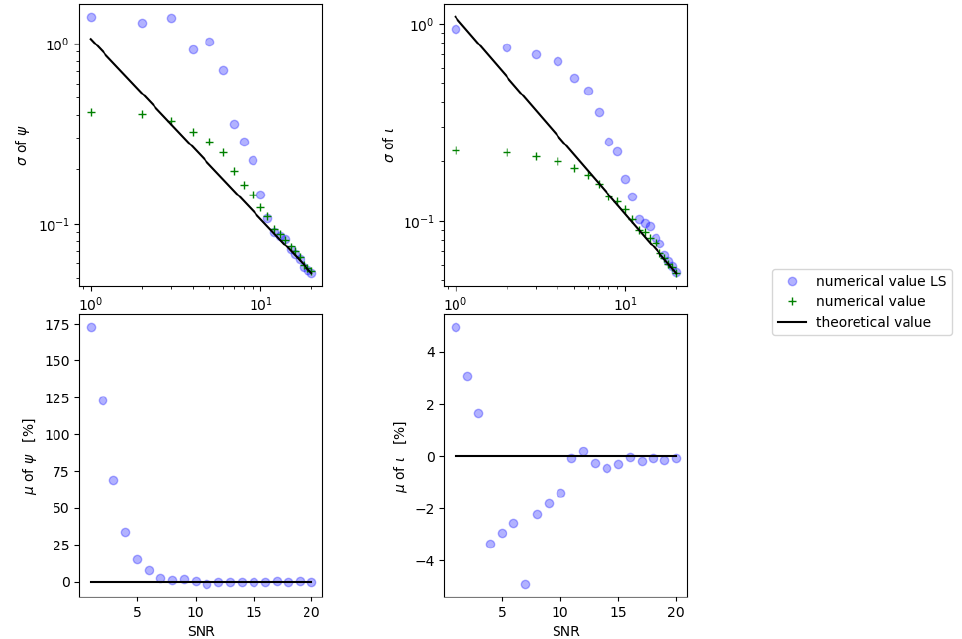
Figure 7. Bias and standard deviation of estimators of angles ψ ( left panels) and ι ( right panels). The crosses are for initial estimators obtained from the Equations(137) and (138) and the dots are for the estimators from the least-squares procedure. Continuous lines are theoretical predictions from the Fisher matrix. The standard deviation is a log-log